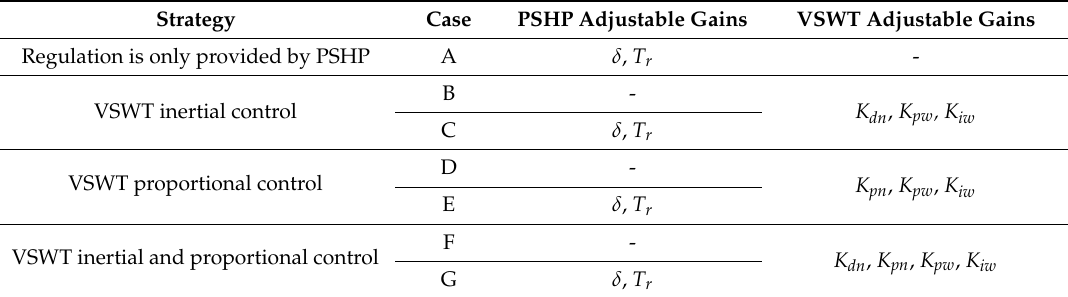
Table 1. Exhaustive summary of search cases.